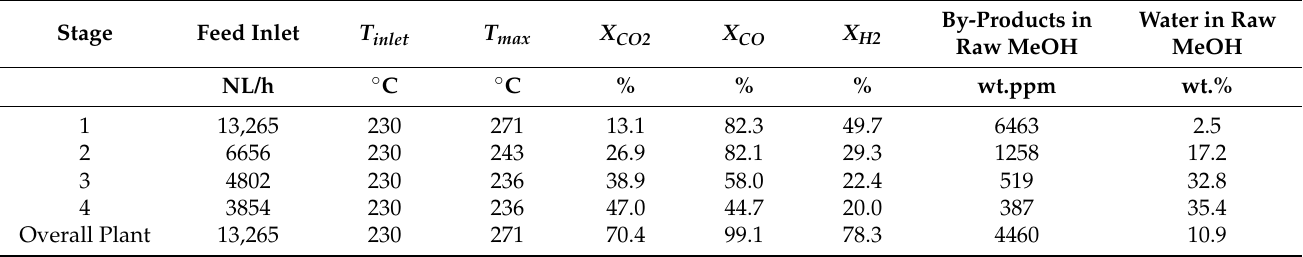
Table 7. Conversion of CO 2 , CO, and H 2 in each stage and for the overall plant at high load (13,265 NL/h (7.52 kg/h)) in the four-stage methanol plant (T = 230 ◦ C, p = 80 bar); time of sampling: 9.50 h (end of